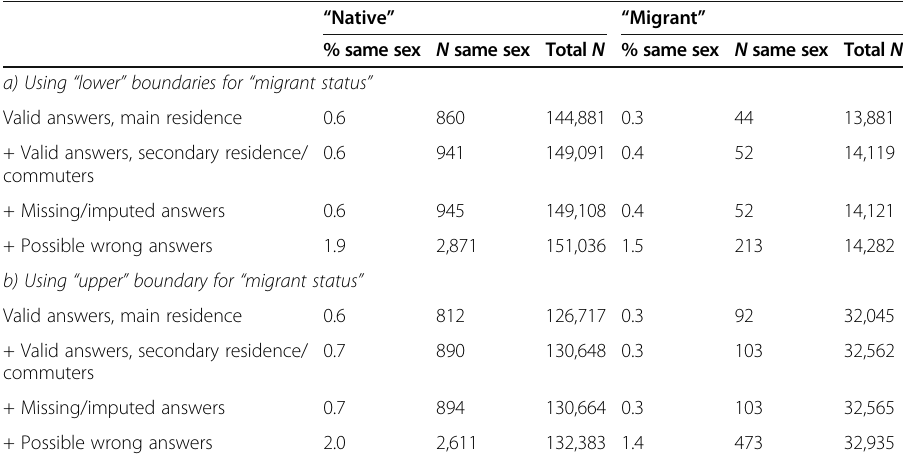
Table 2 Individuals in same-sex couples in Germany, by “ reporting type ” and “ migrant status ” “ Native ” “ Migrant ” % same sex N same sex Total N % same sex N same sex Total